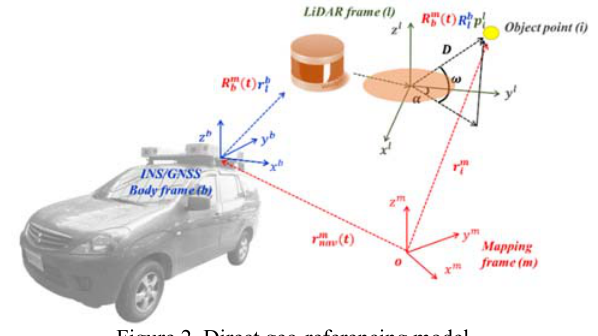
Figure 2. Direct geo-referencing model